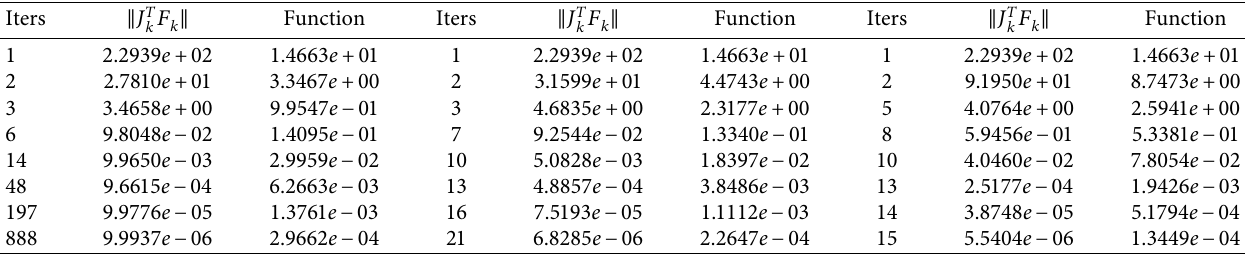
F ‖ < 10 − 5 , λ � ‖ J T F ‖ δ with k k k k k